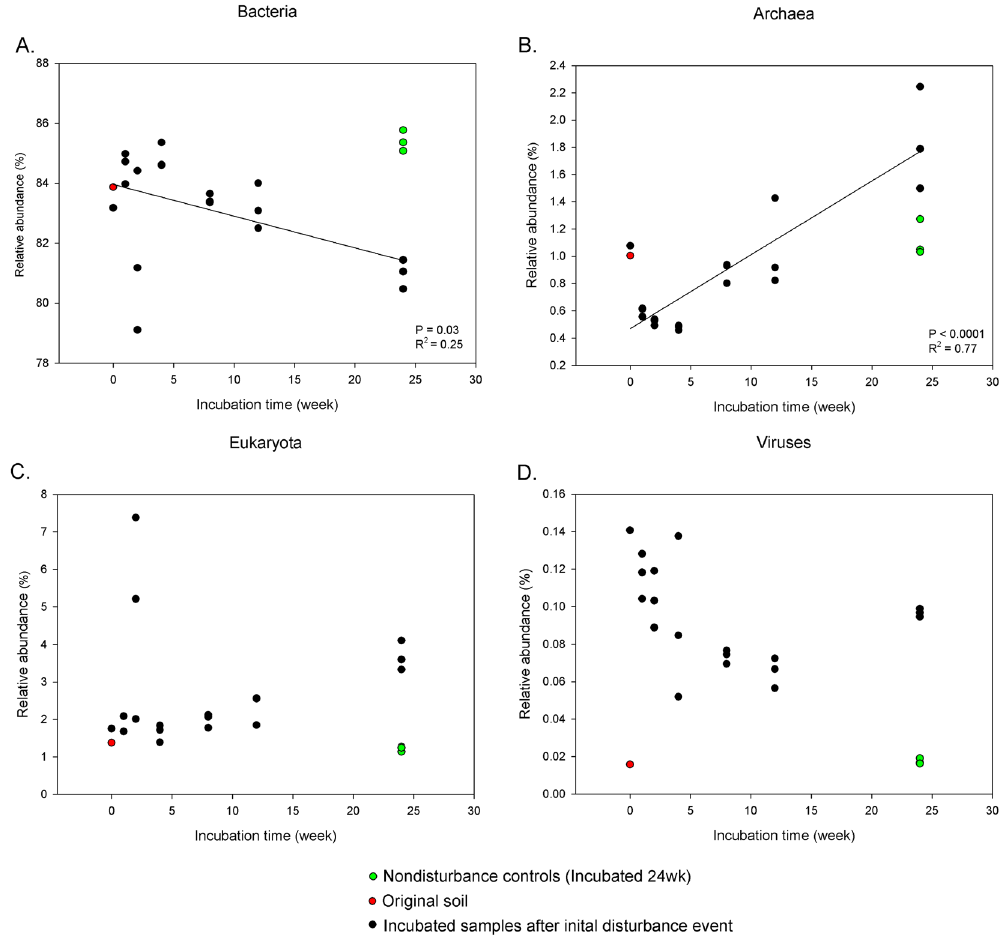
Figure 1. Relative abundance of each domain level assigned based on the M5NR database. Solid line represents linear regression fits to data. Relative abundance of ( A ) Bacteria, ( B ) Archaea, ( C ) Eukaryota, ( D ) Viruses. Colored points were not included in the